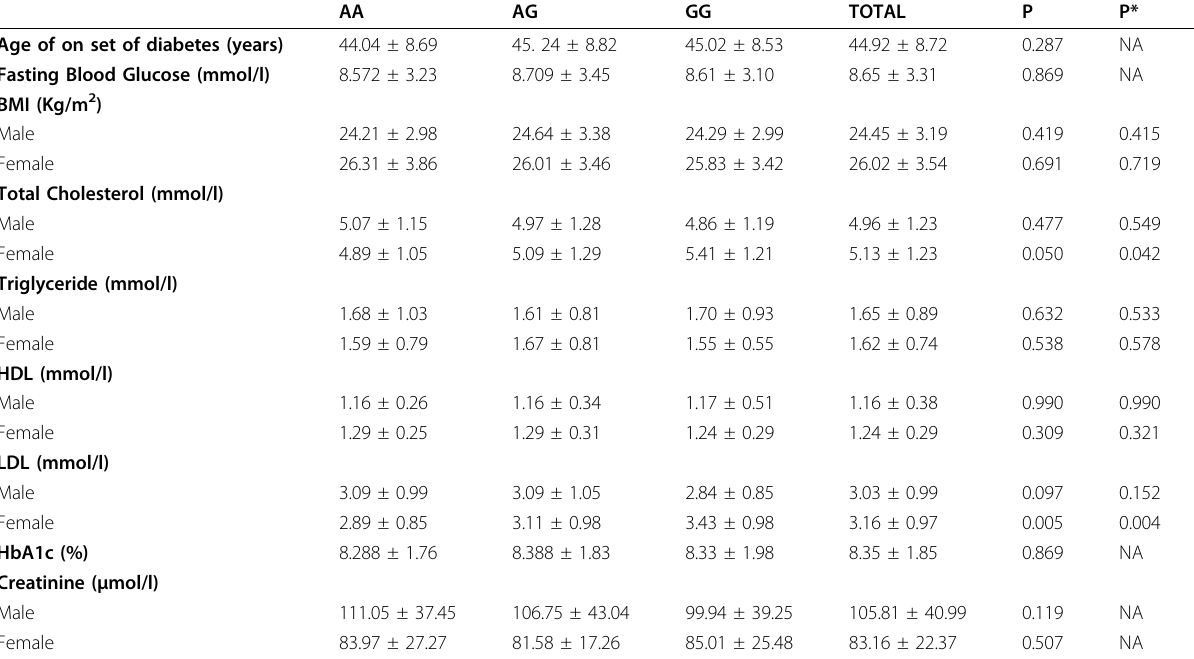
Table 4 Association analysis of SNPs rs 2291726 with biochemical parameters in